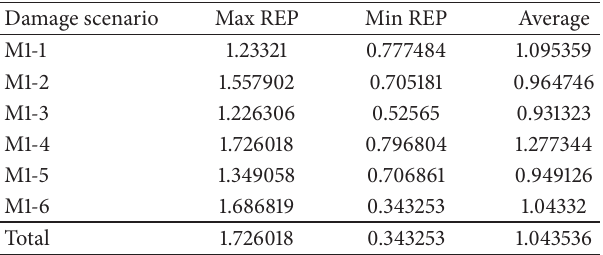
Table 12: REP ranges in different scenarios. adj,adm Damage scenario